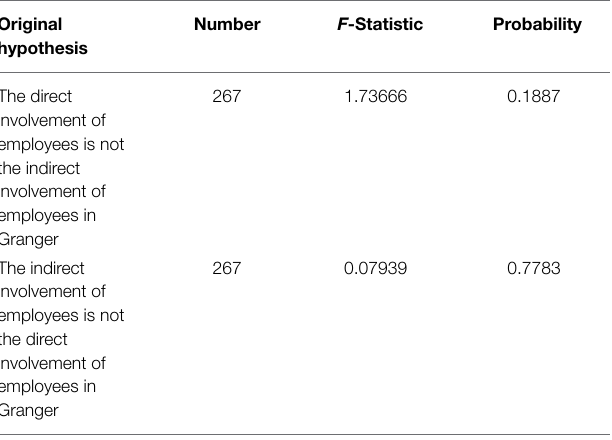
TABLE 2 | Results of the Granger test with employee direct involvement and employee indirect involvement.